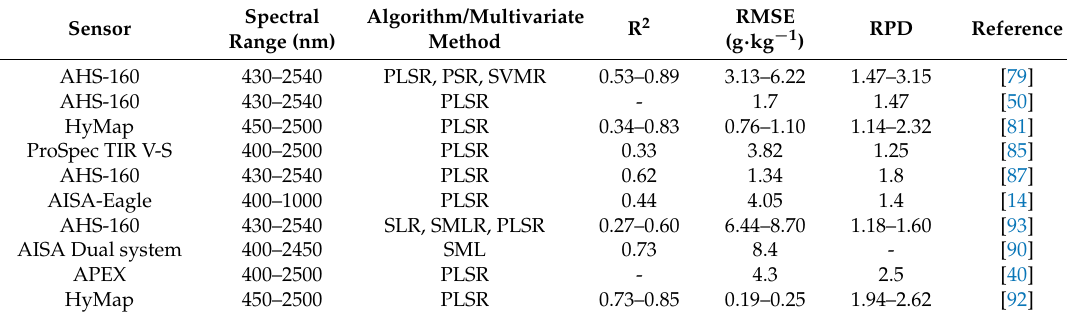
Table 2. Studies for SOC estimation with the use of airborne